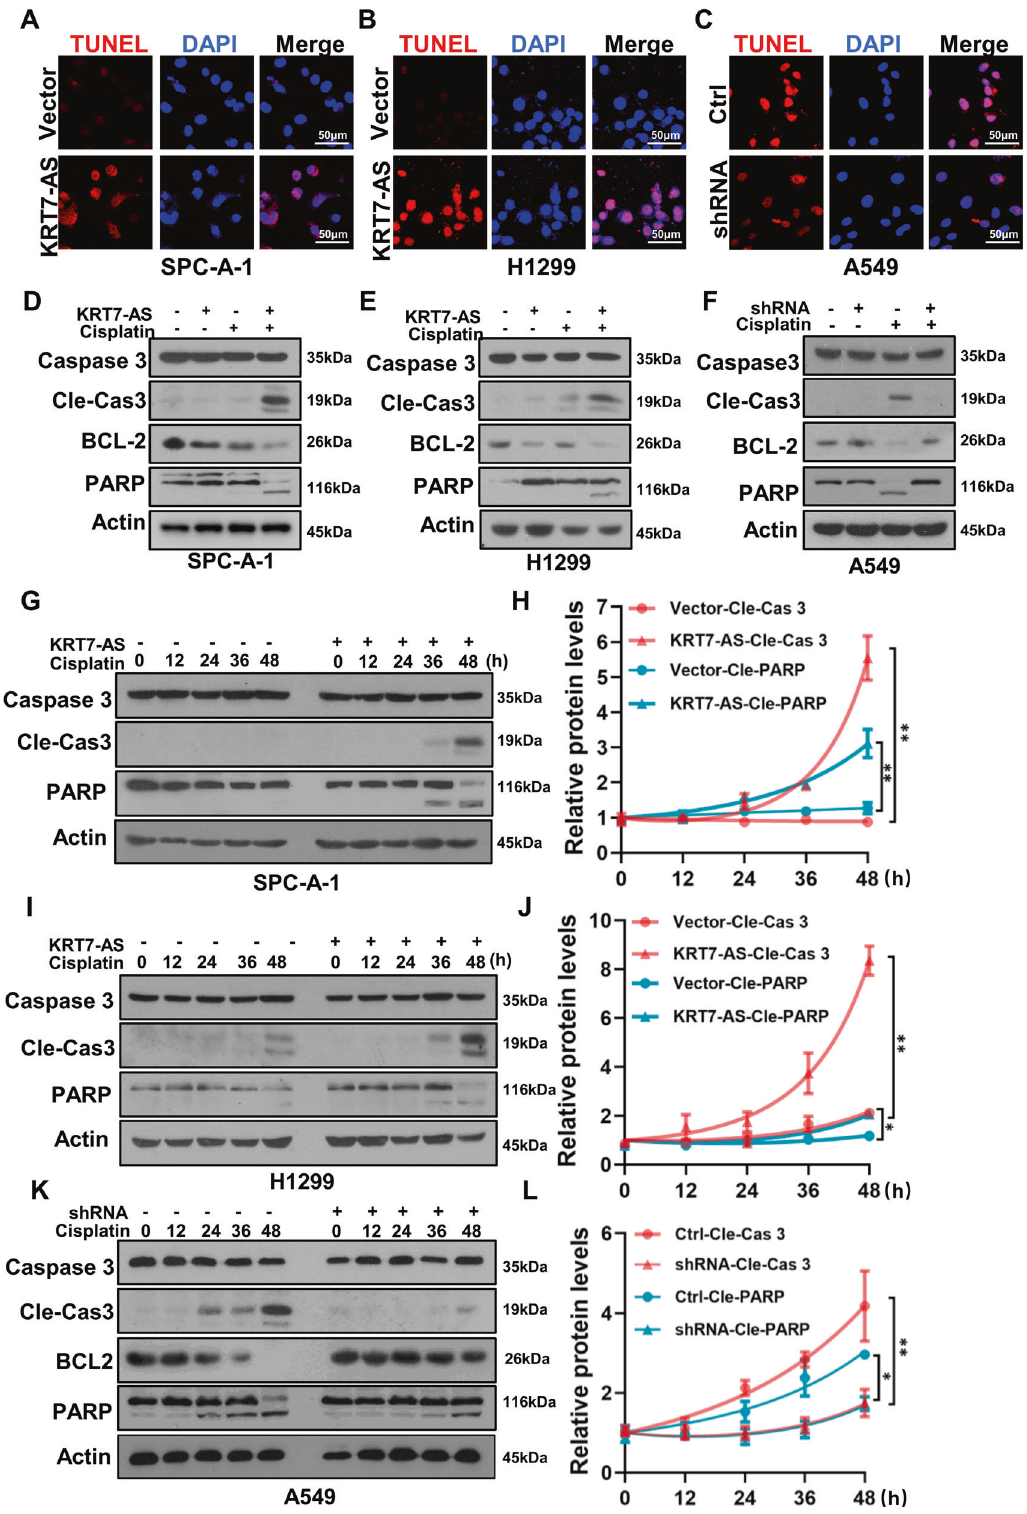
Fig. 5 KRT7-AS enhances cisplatin-induced apoptosis and activates apoptotic signaling pathways in cancer cells. TUNEL assay showed that KRT7-AS enhanced cisplatin-induced apoptosis in SPC-A-1 ( A ) and H1299 ( B ) lung cancer cells, whereas, silencing of KRT7-AS in A549 ( C ) lung cancer cells reduced apoptosis. The levels of Caspase 3, cleaved-Caspase 3, BCL-2, and PARP in KRT7-AS-overexpressed SPC-A-1 ( D ) and H1299 ( E ) lung cancer cells, or KRT7-AS-silenced A549 ( F ) lung cancer cells were measured by Western blotting. Time course study showed that KRT7-AS elevated the levels of cleaved-Caspase3 and cleaved PARP in cisplatin concentration- and time-dependent manner ( G – L ). Data are shown as mean ± SD of three independent replicates. * P < 0.05, ** P < 0.01.